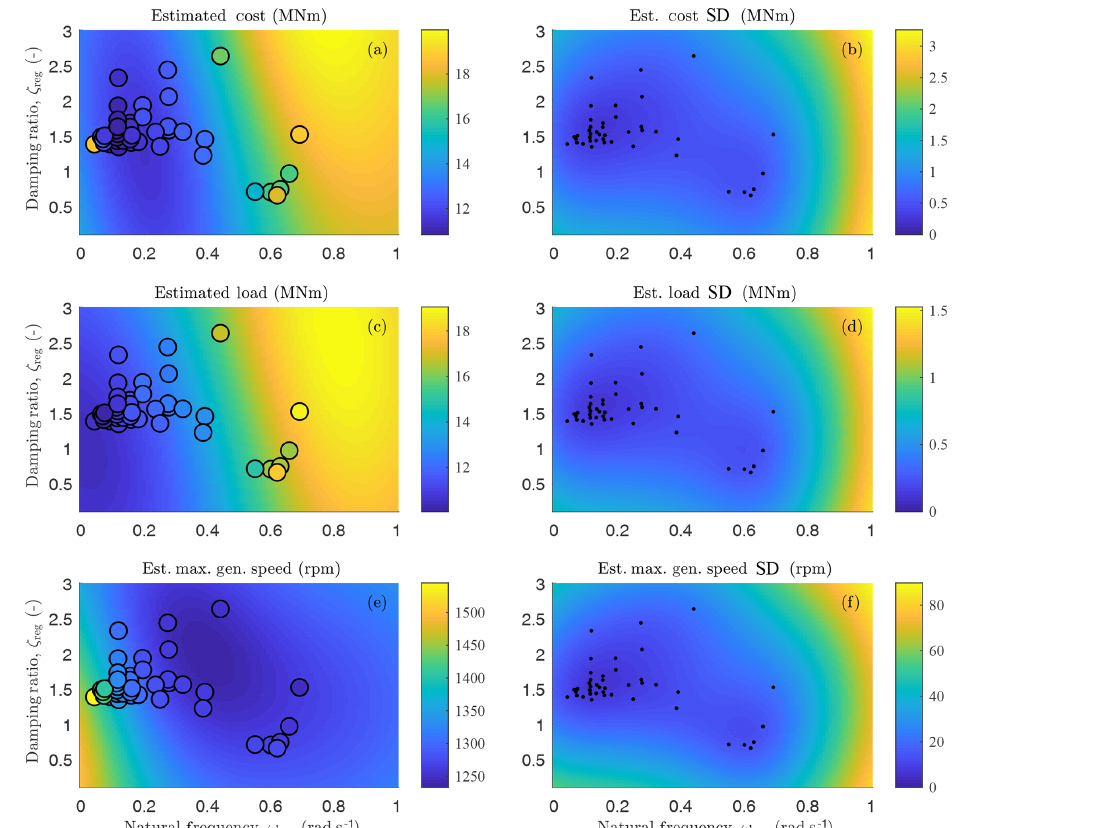
Figure 5. Cost (a) , load (c) , and generator speed (e) estimated values and standard deviations (SD; b , d , and f ) using the kriging visualization described in Sect. 2.6. The sample values are shown in (a) , (c) , and (e) , and their locations are depicted in (b) , (d) , and (f)